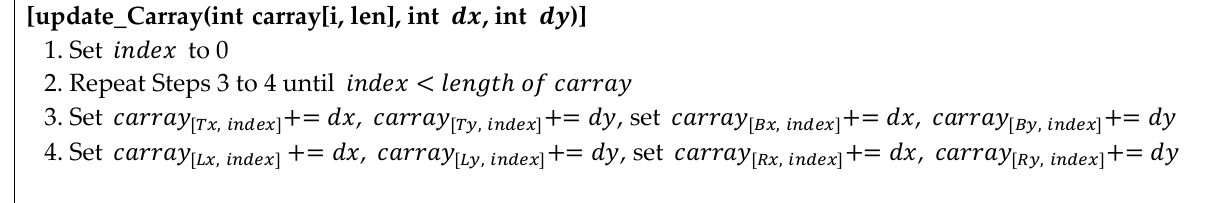
Figure 16. Proposed algorithm for movement to the right and bottom. The pseudocode for updating the circular coordinate array is shown in Figure 17.